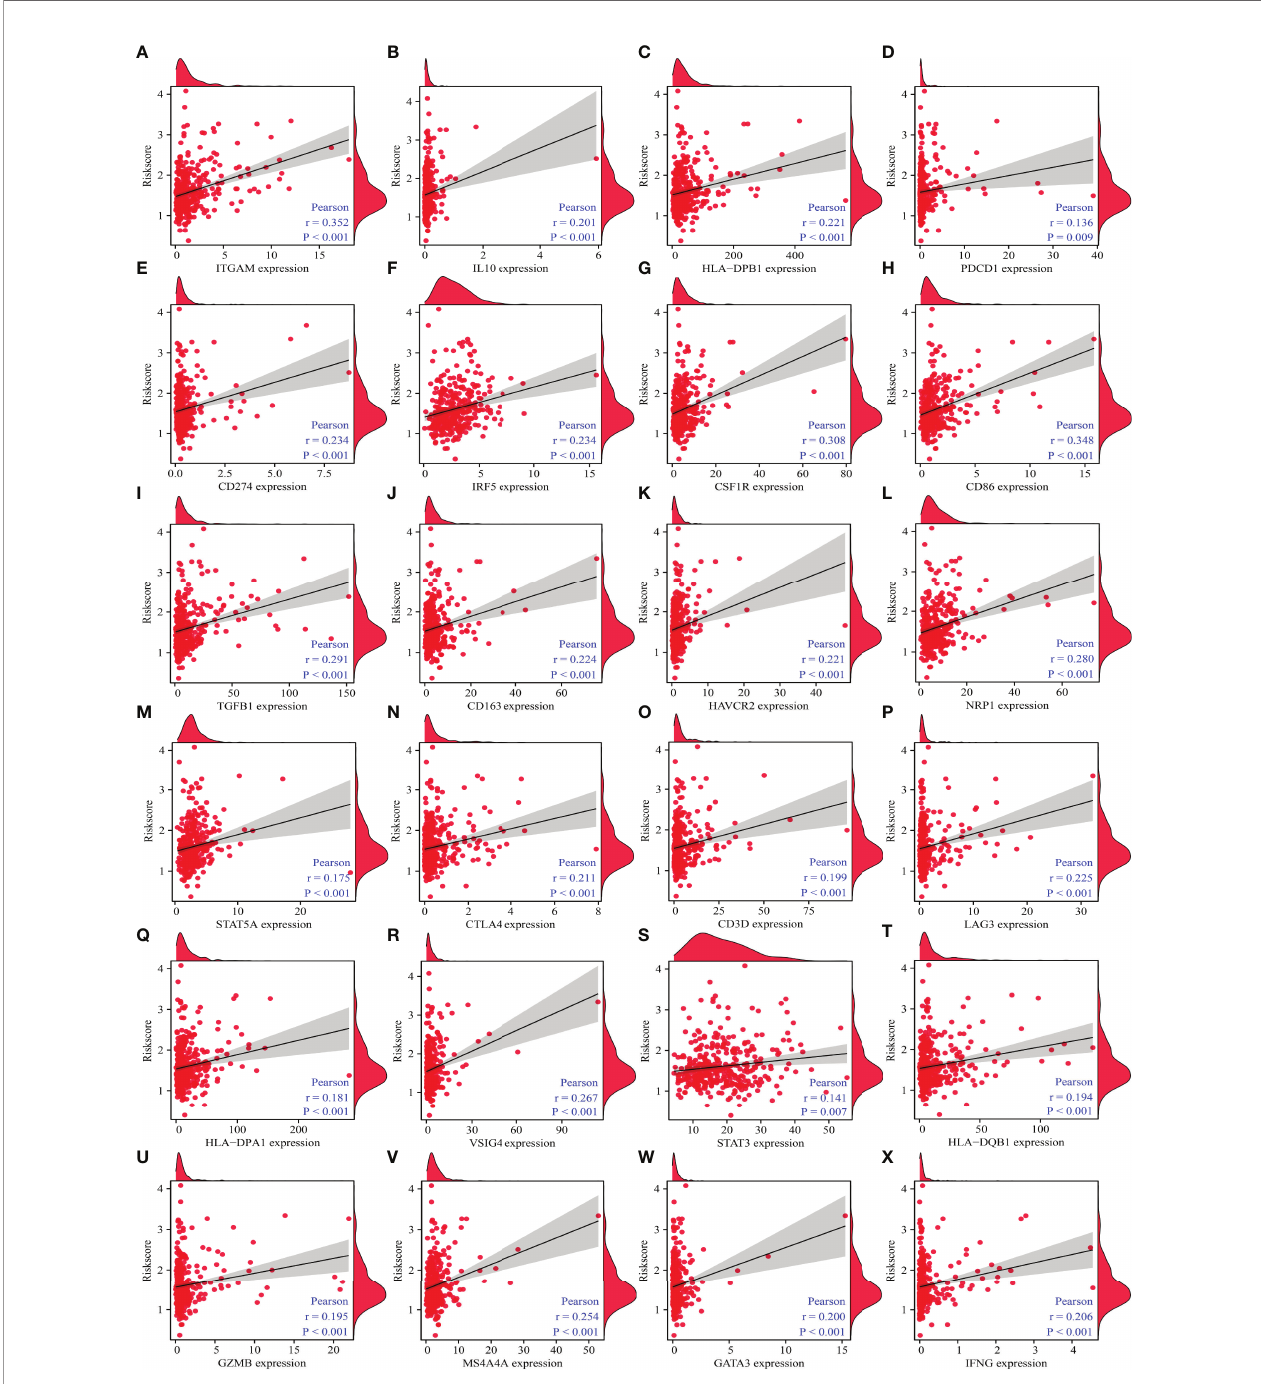
FIGURE 10 | The correlation between the risk model and HCC immune-in fi ltrating cell markers. (A) ITGAM; (B) IL10; (C) HLA-DPB1; (D) PDCD1; (E) CD274; (F) IRF5; (G) ; CSF1R; (H) CD86; (I) TGFB1; (J) CD163; (K) HAVCR2; (L) NRP1; (M) STAT5A; (N) CTLA4; (O) CD3D; (P) LAG3; (Q) HLA-DPA1; (R) VSIG4; (S) STAT3; (T) HLA-DQB1; (U) GZMB; (V) MS4A4A; (W) GATA3; (X) IFNG. HCC, hepatocellular